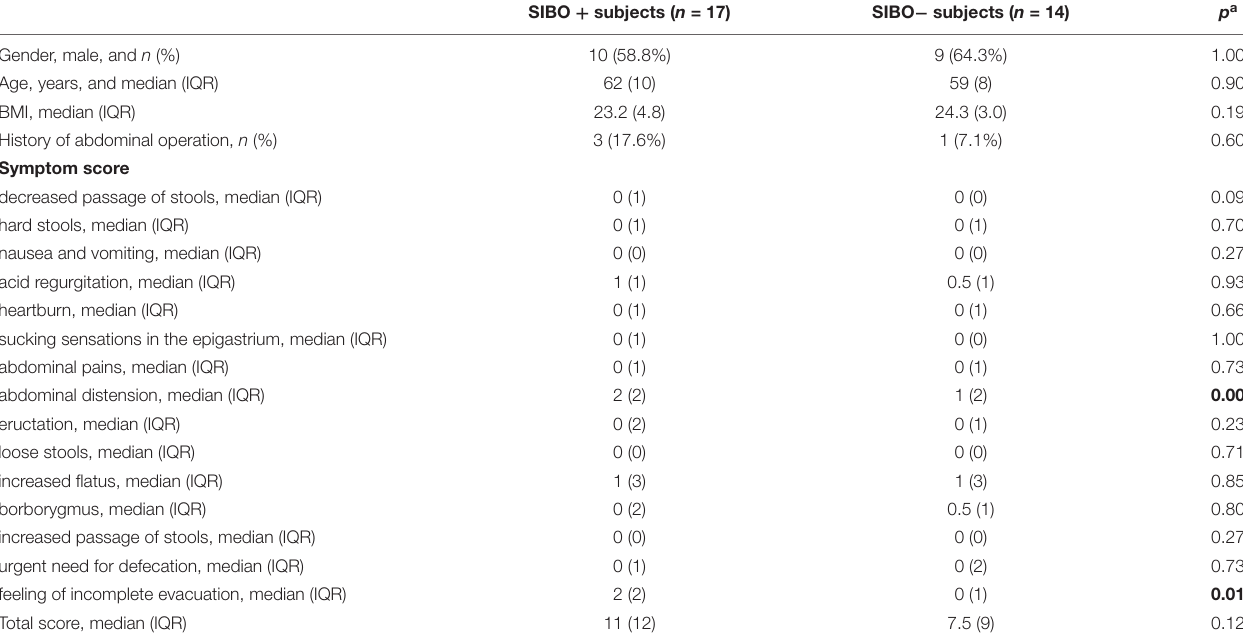
TABLE 1 | Demographic and clinical characteristics of SIBO + and SIBO −